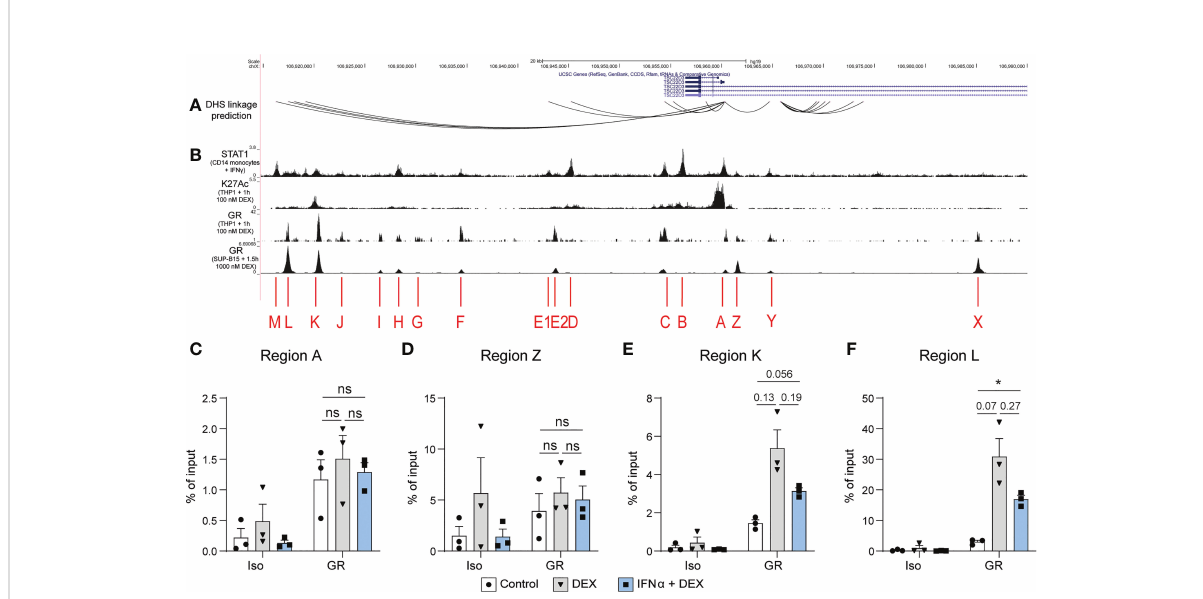
FIGURE 5 DEX-induced GR binding at a putative GILZ enhancer is reduced after IFN a pre-treatment. (A) DHS linkage predictions are mapped to indicate potential looping regulatory regions connected to the GILZ promoter (19). (B) ChIP-seq data of STAT1 binding in CD14+ monocytes treated with IFN g (GSE99887), H3K27Ac histone acetylation and GR binding in THP1 cells treated with 100 nM DEX (GSE43036) and GR binding in SUP- B15 cells treated with 100 nM DEX (GSE107584). (C – F) ChIP for GR in L363 cells treated with DEX or IFN a and DEX. Enrichment was assessed in regions (C) A, (D) Z, (E) K and (F) L as indicated in fi gure B. n=3 from three independent experiments. ns, Not signi fi